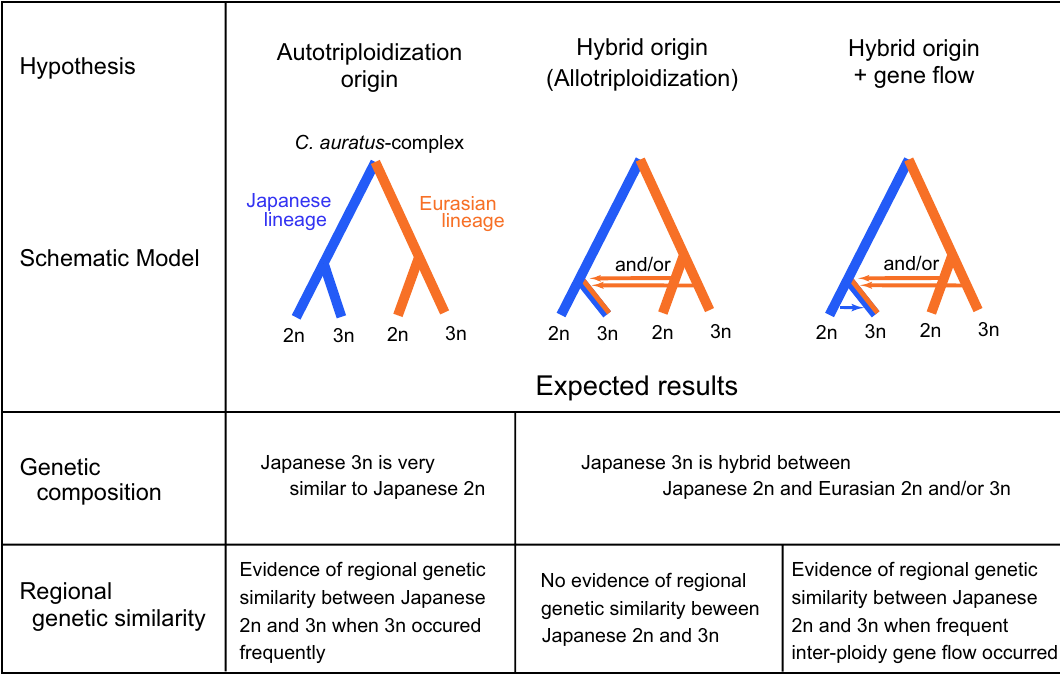
Figure 1. Tested hypotheses about the origin of the Japanese triploid C. auratus -complex investigated in this study and expected analysis